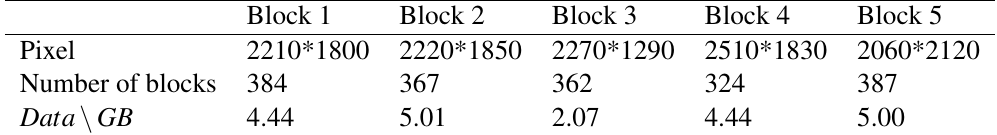
Table 4 The training data in tomb mural blocks in Crown Prince